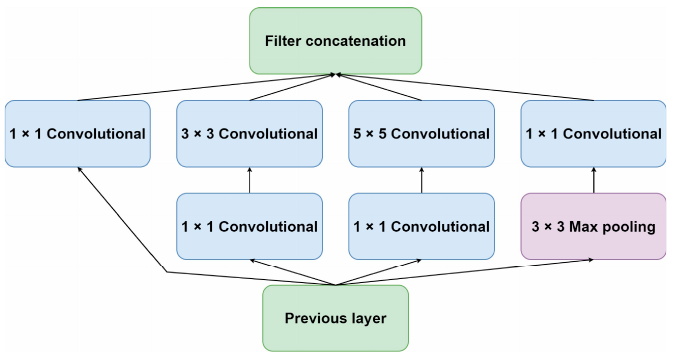
Figure 9. Inception module.